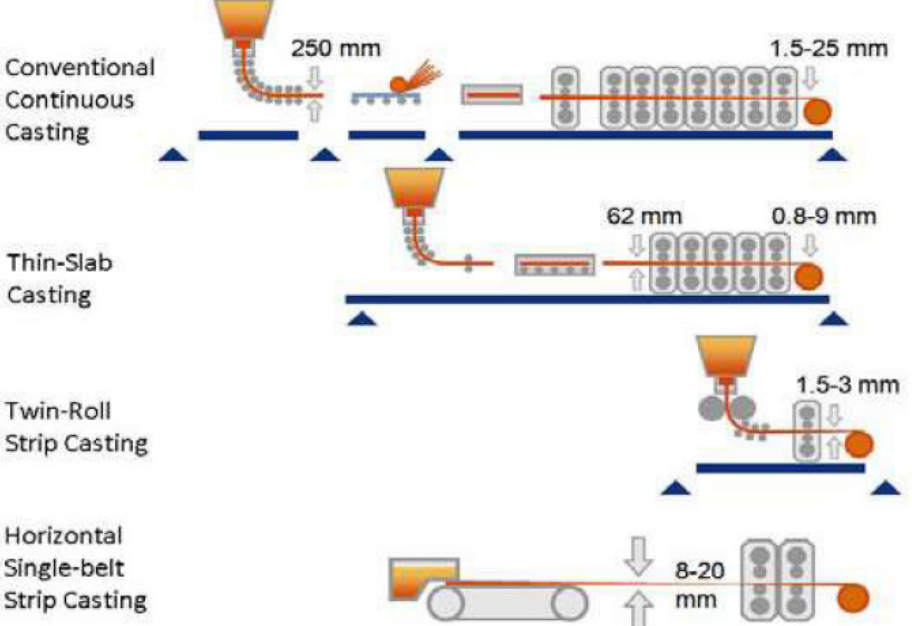
Figure 3. Past and recent commercial developments in strip casting technologies. Typical process layout and equipment for various forms of continuous casting. [5].